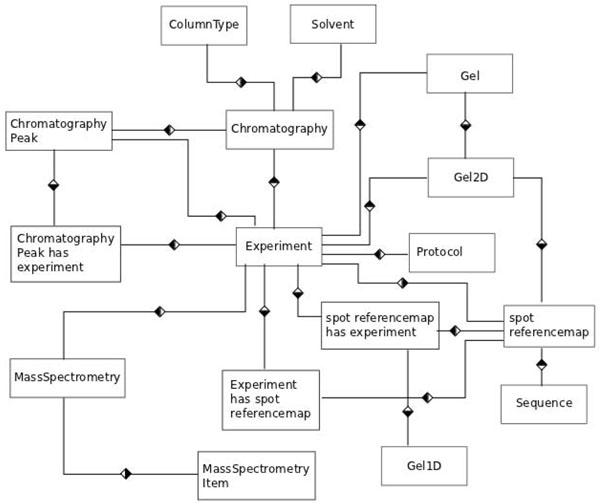
PRODIS data model.